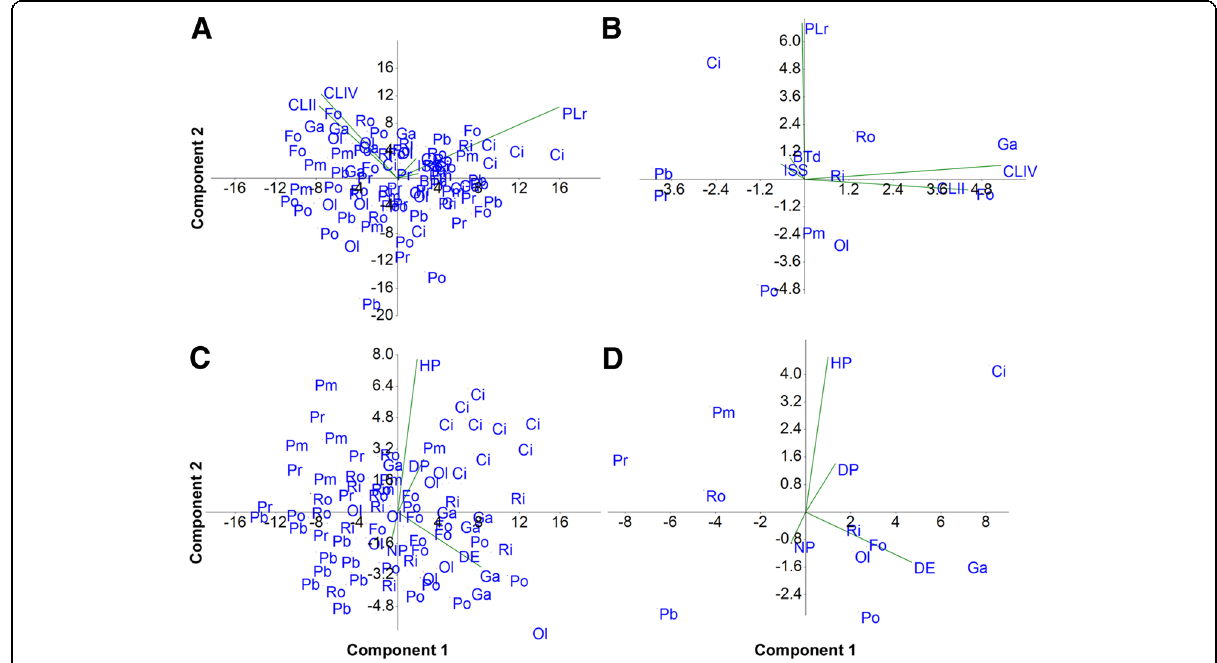
Fig. 4 Principal Component Analysis (PCA) plots showing the multivariate variation among animals ( a and b ) and eggs ( c and d ) in terms of morphometric data. Vectors (green) indicate the direction and strength of each morphometric variable to the overall distribution. a Morphometric data of animals of the different populations. b Mean values of the morphometric data of animals in the different populations. c Morphometric data of eggs of the different populations. d Mean values of the morphometric of the data of the eggs in the different populations. Populations: CI=Clare Island; Fo=Formigine; Ga=Gaggio; PB=Passo Ballino; PM=Piane di Mocogno; Po=Pondel; Pr=Prodo; Ol=Olbia; Ri=Riccò; Ro=Rocchetta; for more information see Table 1. Morphometric data (according to Table 2, Additional file 1: Table S3): BTd= pt buccal tube diameter; ISS= pt insertion of the stylet support point; CLII= pt second claw pair; CLIV= pt fourth claw pair; PLr= pt macroplacoids row; DE=diameter of the egg; DP=diameter of the egg process; HP=height of the egg process; NP=number of processes per hemisphere. The first and second principal components explained the following variance, respectively: a 45.30 and 40.51%; b 53.70 and 39.68%; c 77.18 and 14.34%; d 81.81 and